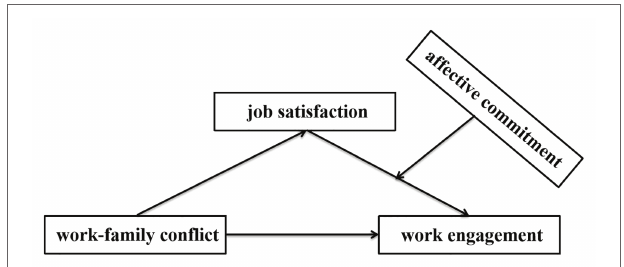
FIGURE 1 | The hypothesized model of moderated